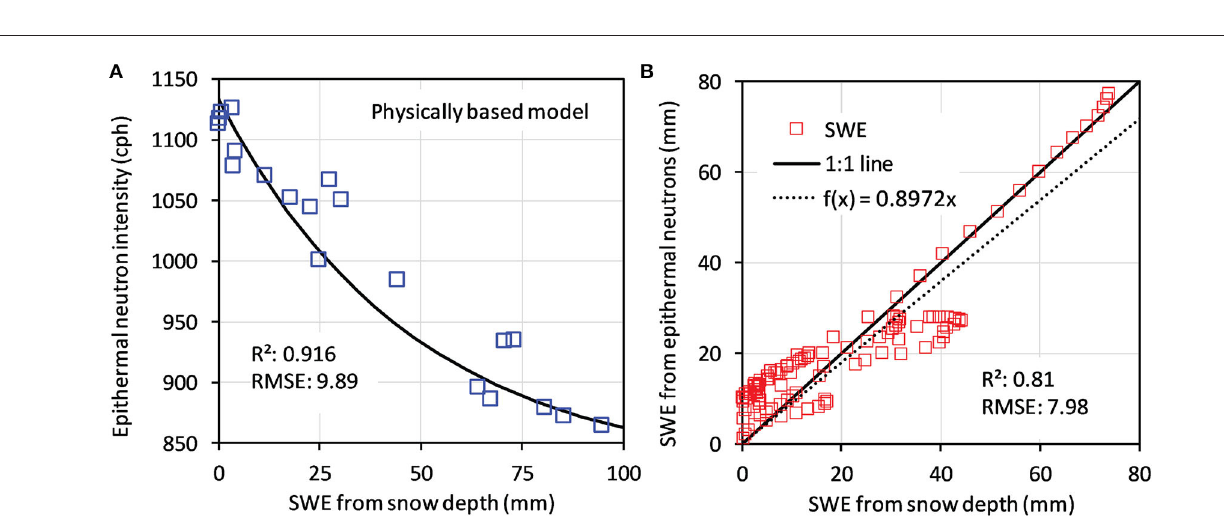
FIGURE 9 | (A) Physically-based model of Desilets (2017) fitted to 20 selected SWE values obtained from snow level measurements using Equation (10); (B) validation of the physically-based model using all SWE